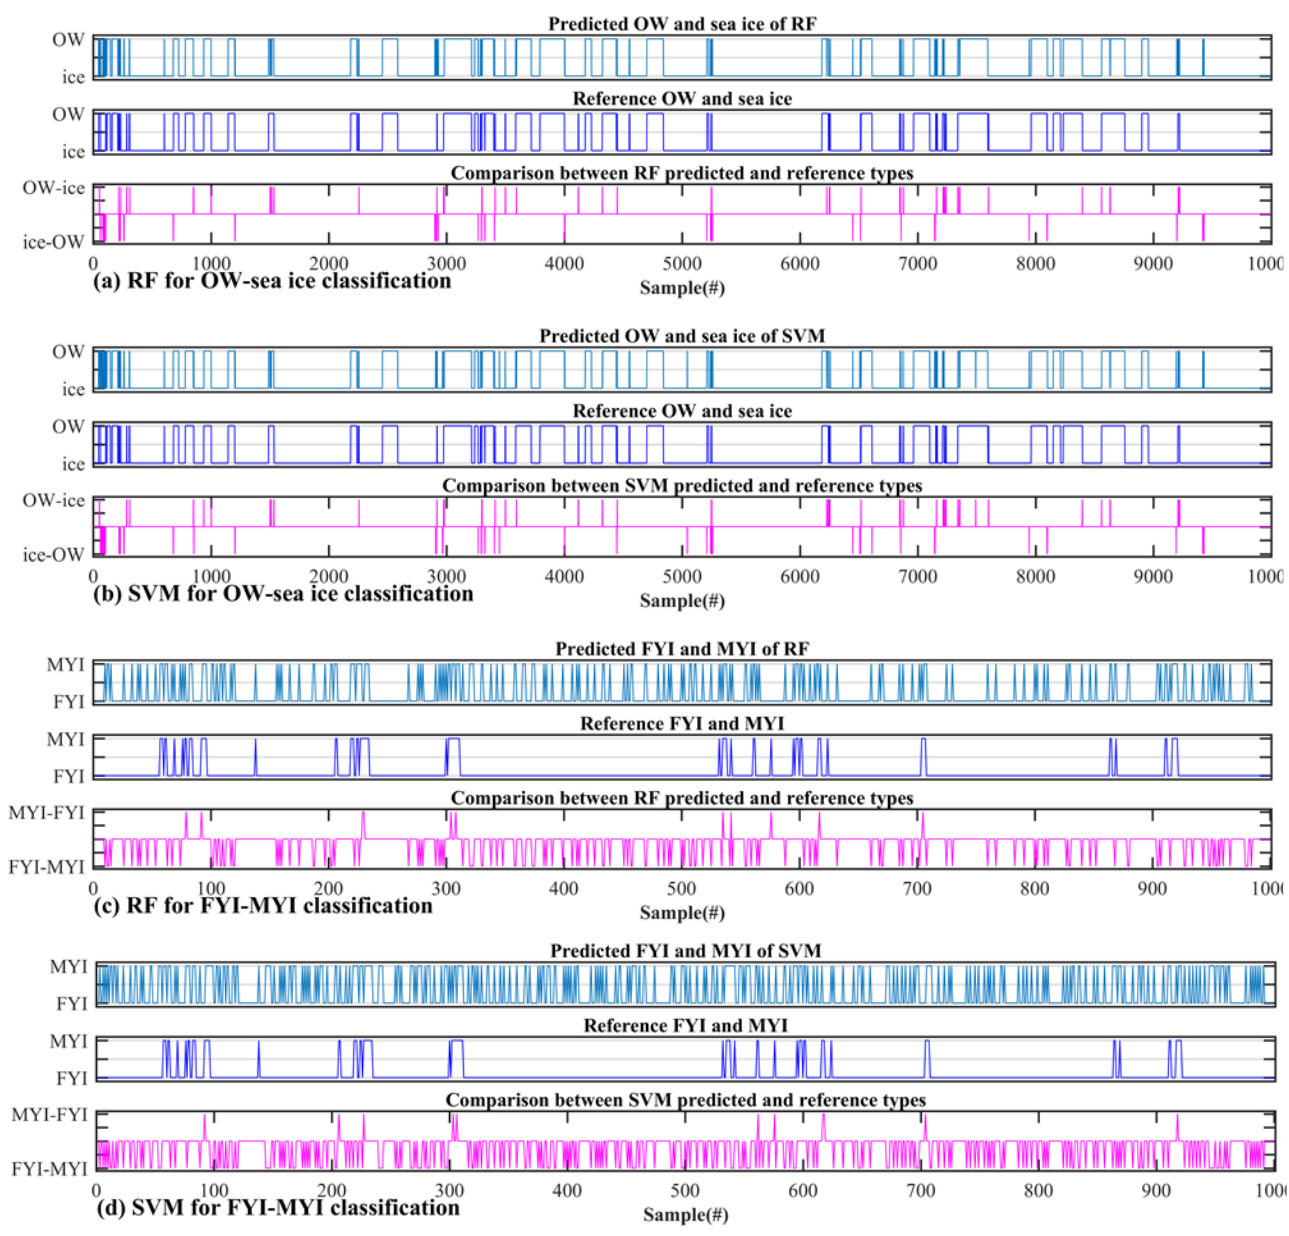
Figure 12. Classification results of random forest (RF) and support vector machine (SVM) classifiers. ( a ) Reference open water (OW) and sea ice. ( b ) Predicted OW and sea ice of RF. ( c ) Predicted OW and sea ice of SVM. ( d ) Reference first-year ice (FYI) and multi-year ice (MYI). ( e ) Predicted FYI and MYI of RF. ( f ) Predicted FYI and MYI of SVM.